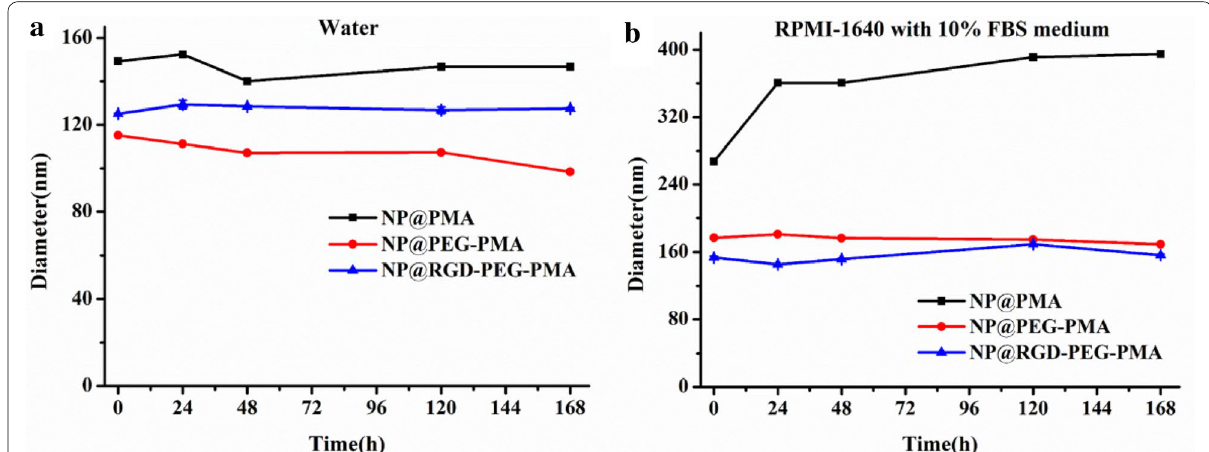
Fig. 4 Stability profiles of different nanocrystals. Changes in the size of nanoparticles after incubation a with water; b with RPMI‑1640 medium supplemented with 10% FBS